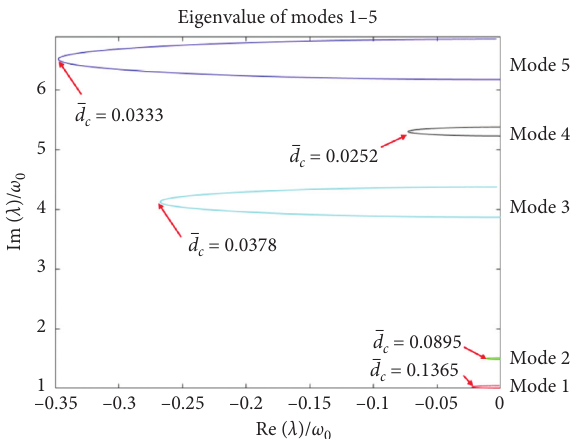
Figure 13: Root locus for varying joint damping ( k